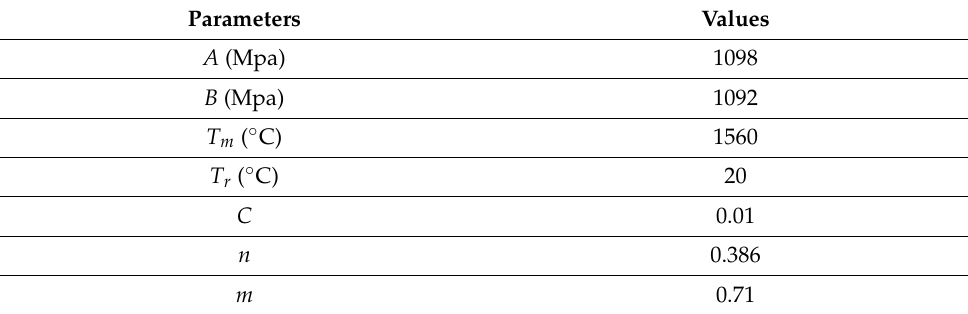
Table 1. Material properties of TC4 [24].